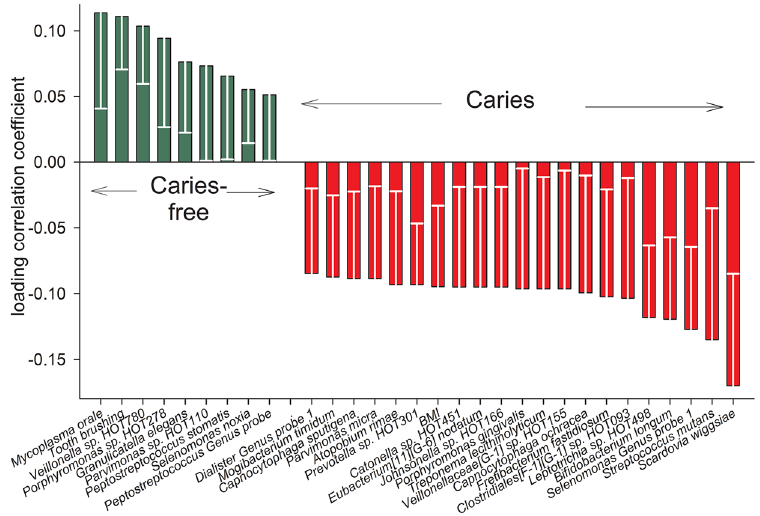
Figure 5. PLS loading column plot. Mean (95% CI) PLS correlation coefficients for the top 20 taxa associated with having caries and all taxa associated with being caries-free. The PLS model included caries as dependent variable and saliva detected species level taxa, sex, BMI, oral hygiene, and sweet snacking, as the independent block. w describes the PLS weights from the combination of the original variables in the X-swarm and c the same for the Y-swarm. A variable is considered statistical significant when the 95% CI of the correlation coefficient does not include